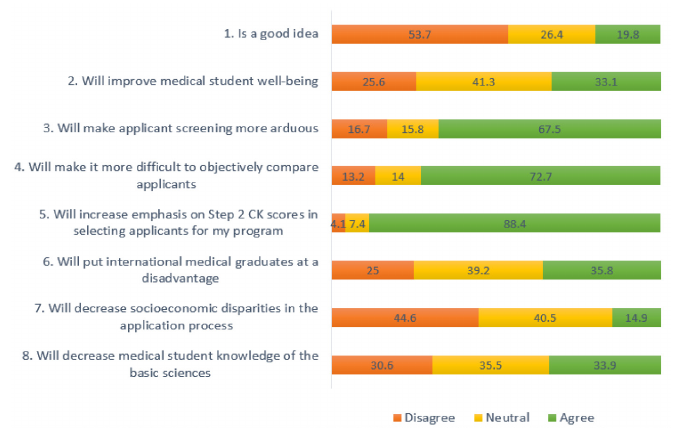
Figure 1. Program directors’ responses to the planned use of binary scoring for USMLE* Step 1. *United States Medical Licensing Exam. CK, clinical knowledge.